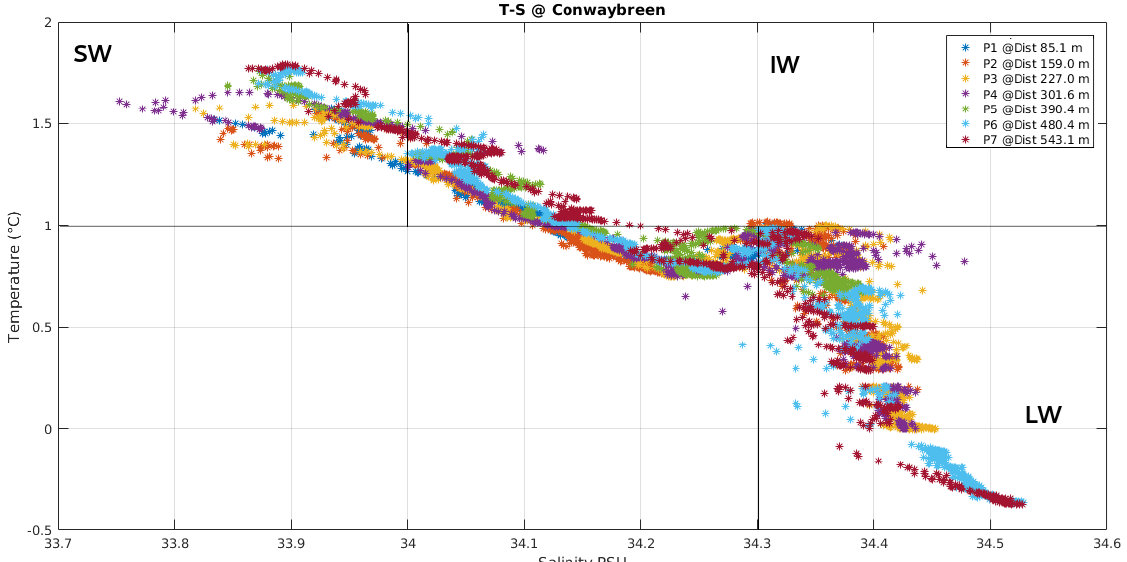
Figure 9. Graph showing in different colors the temperature ( y -axis, °C) and salinity ( x -axis, PSU) data of the different vertical CTD profiles. The classification of water masses as shown in Table 1 has been superimposed on these graphs: SW-surface water; IW-intermediate water; LW-local water.